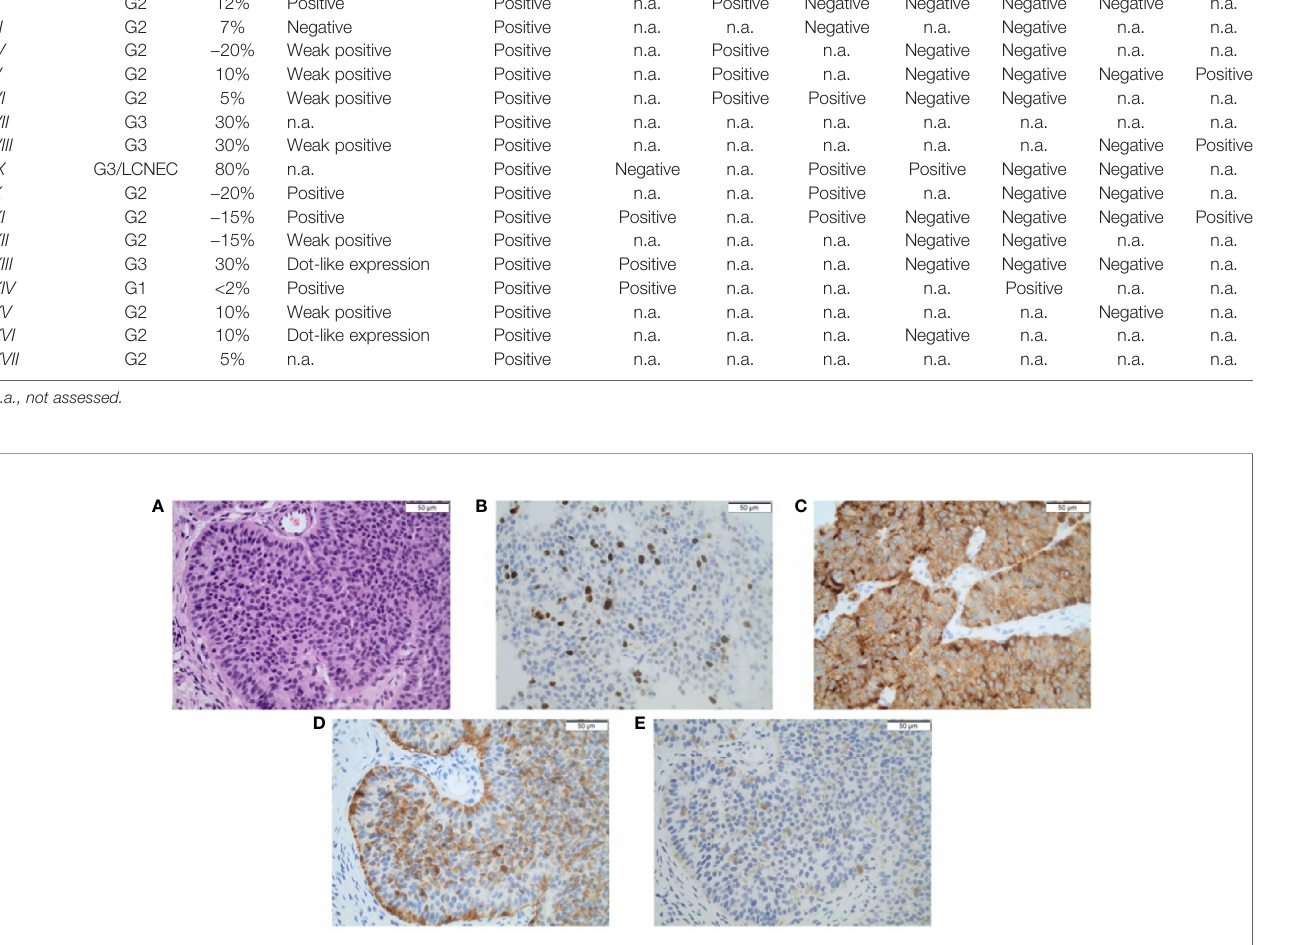
FIGURE 2 | (A) Primary presacral neuroendocrine neoplasm stained using H&E (100×). Immunohistochemical staining (100×) shows a well-differentiated neuroendocrine neoplasm with a (B) Ki67 index of 7% and positivity for (C) synaptophysin, (D) chromogranin a, and (E) PSAP. Scale bars represent 50 µm.